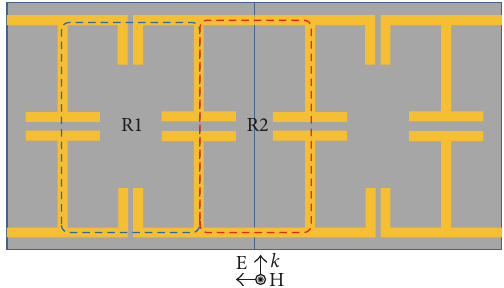
Figure 5: Metallic structure of the dual-band MTM.